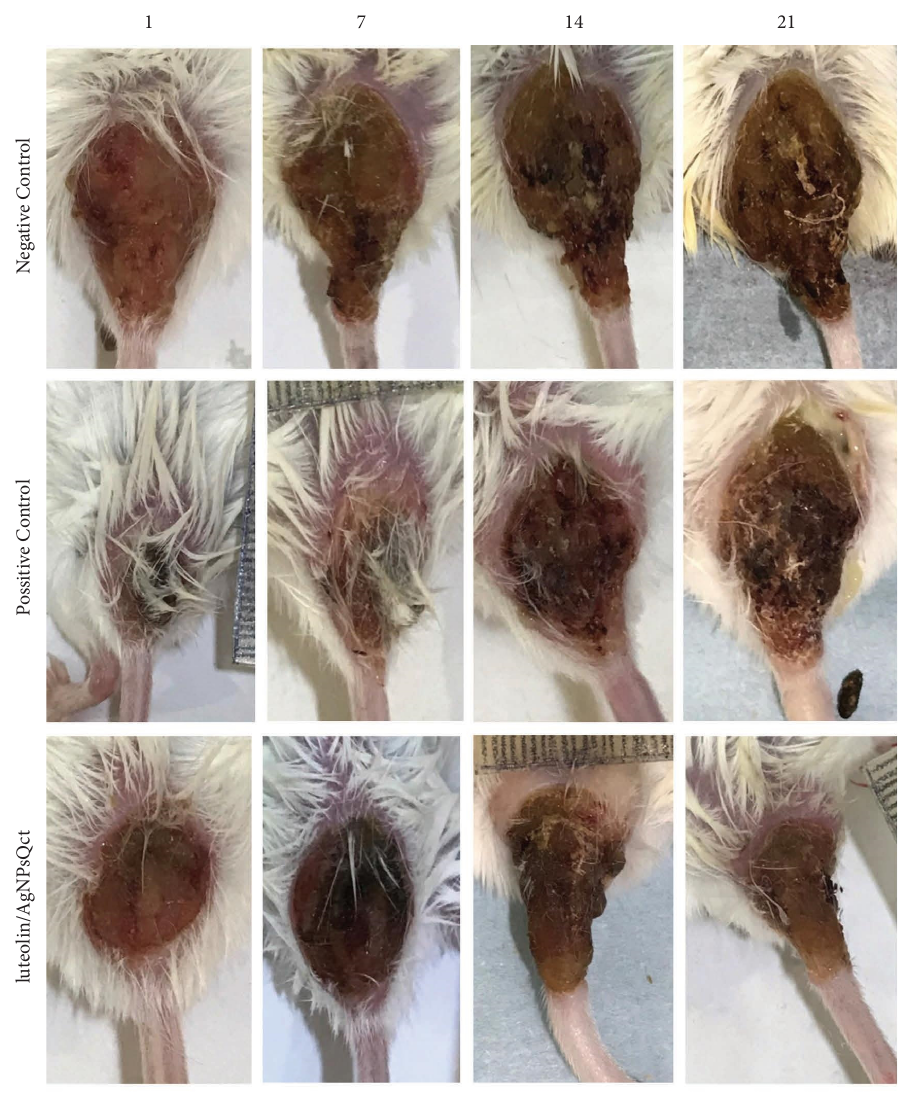
Figure 4: Te image of tail-base wound in mice. Negative control (without treatment) vs. positive control (treatment with glucantime) and the ointment group (treatment with luteolin/AgNPQct ointment) on 1, 7, 14, and 21